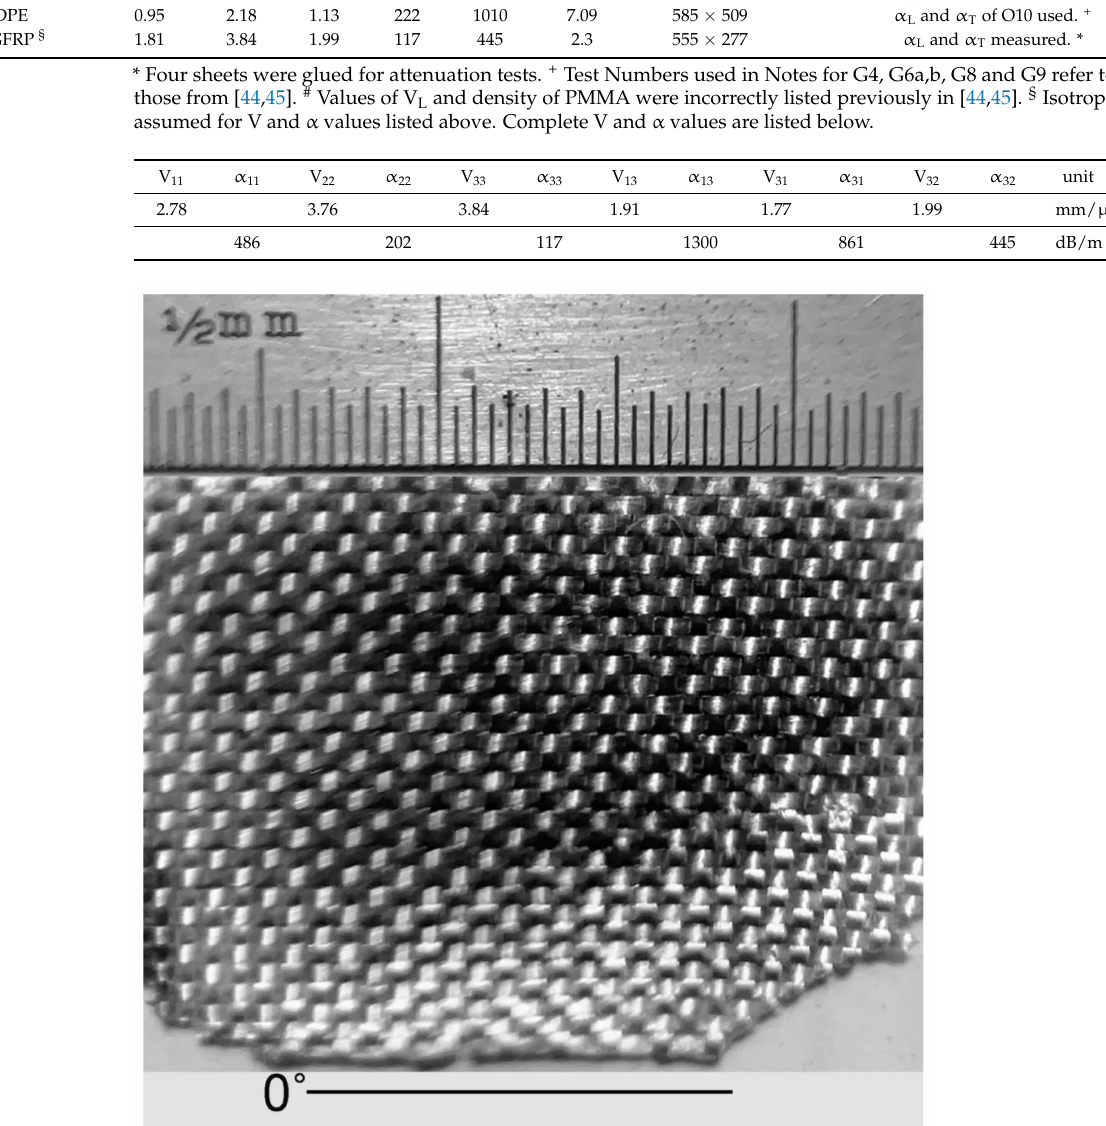
Figure 1. Woven rovings of glass fiber cloth after burning the matrix resin. Lamb wave propagation was along 0 ◦ direction marked. Top scale has 0.5 mm